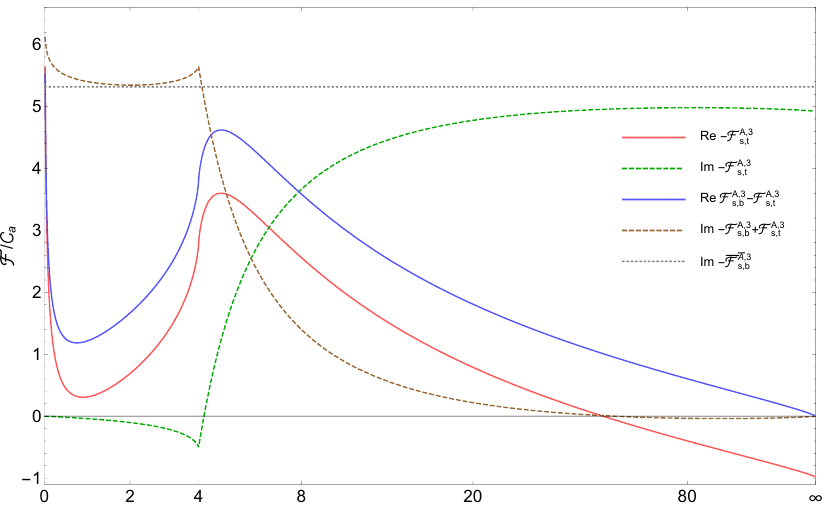
Figure 3 . The exact result for the 3-loop finite remainders defined in eq. (4.10), plotted as function of x = s/m 2 , with values normalized w.r.t. the real part of the 5-flavor massless result C a ≈ t 175 . 218